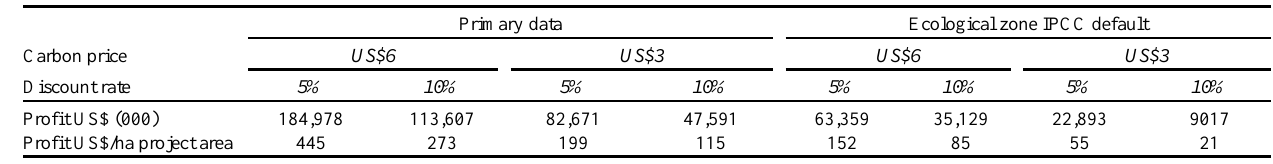
Table 5 . Net present value of profits under different forest carbon stock methods calculated by subtracting the costs of REDD project implementation from revenues generated through sale of emission reductions. Two price scenarios, US$3 and US$6, and two discount rates (5% and 10%) are presented and net profits are given in 2010